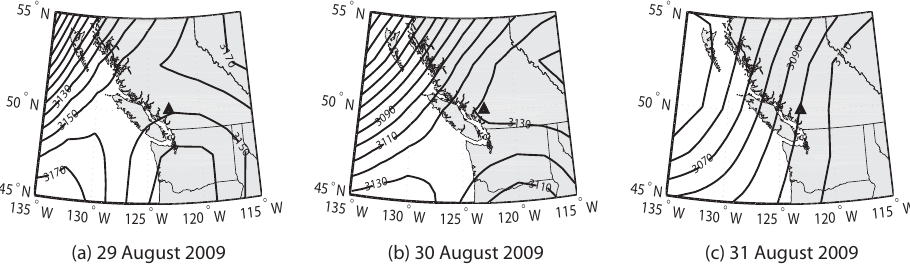
Fig. 2. NCEP reanalysis data showing 700hPa heights (m) from 29–31 August 2009. For each LST day, the height values represent data averaged over the four synoptic observation times. Contour interval 10m. The location of Whistler Mountain is marked by a solid triangle